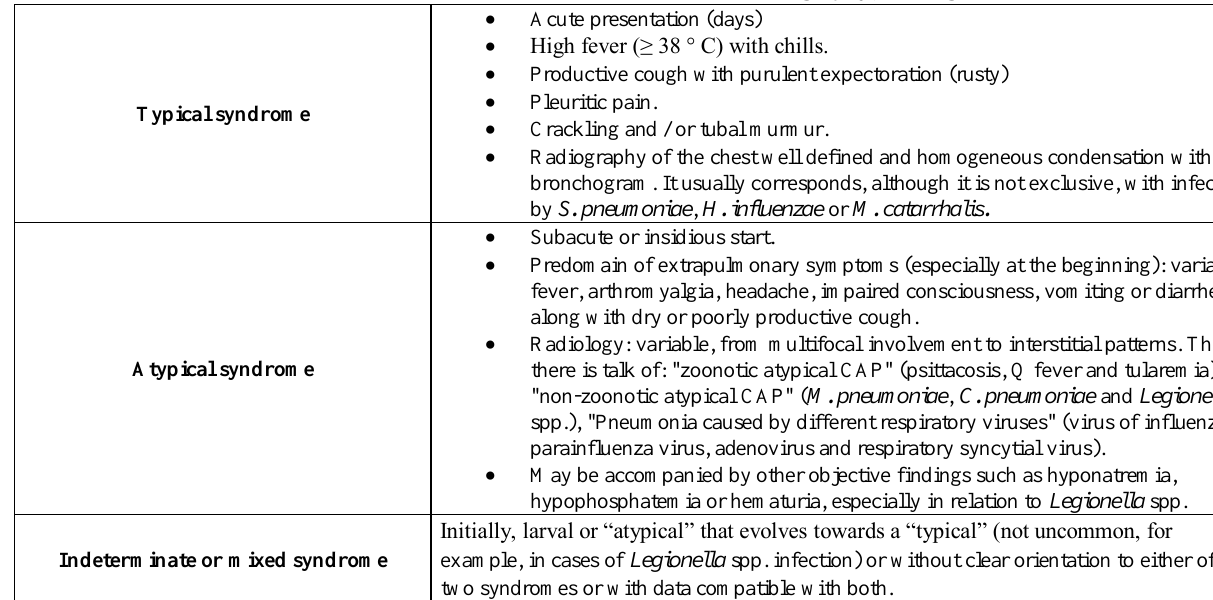
Table 4: CAP syndromes depending on the clinical-radiological presentation form. CAP: Community acquired